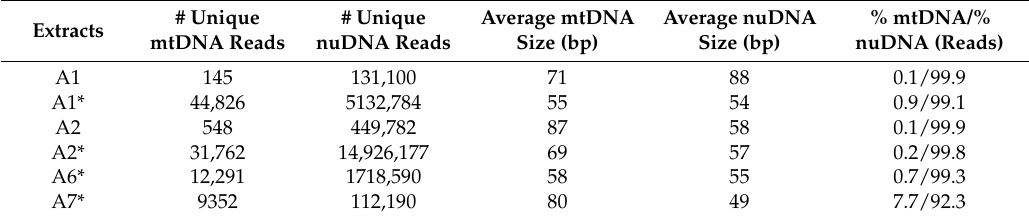
Table 12. Sequencing statistics for single aged hairs. The asterisk denotes DNA extraction using protocol B.